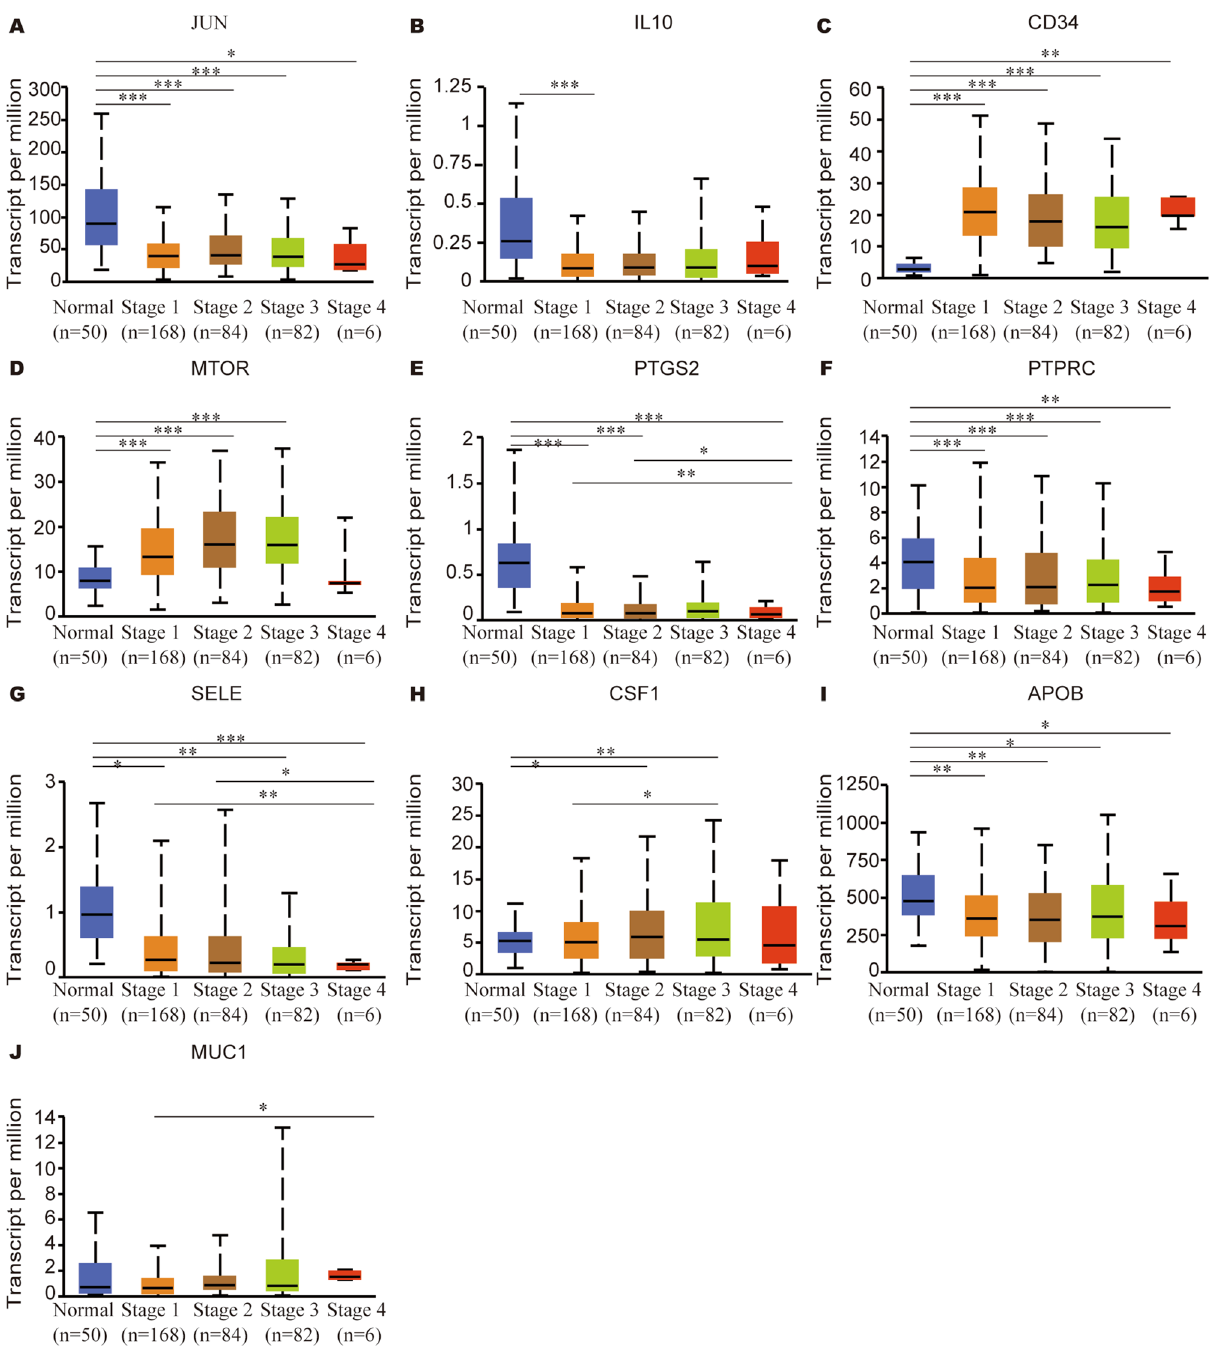
Figure 6. Relationship between mRNA expression of hub genes and individual cancer stages of HCC patients. ( A ) JUN, ( B ) IL10, ( C ) CD34, ( D ) MTOR, ( E ) PTGS2, ( F ) PTPRC, ( G ) SELE, ( H ) CSF1, ( I ) APOB, ( J ) MUC1. *P < 0.05, **P < 0.01, ***P <